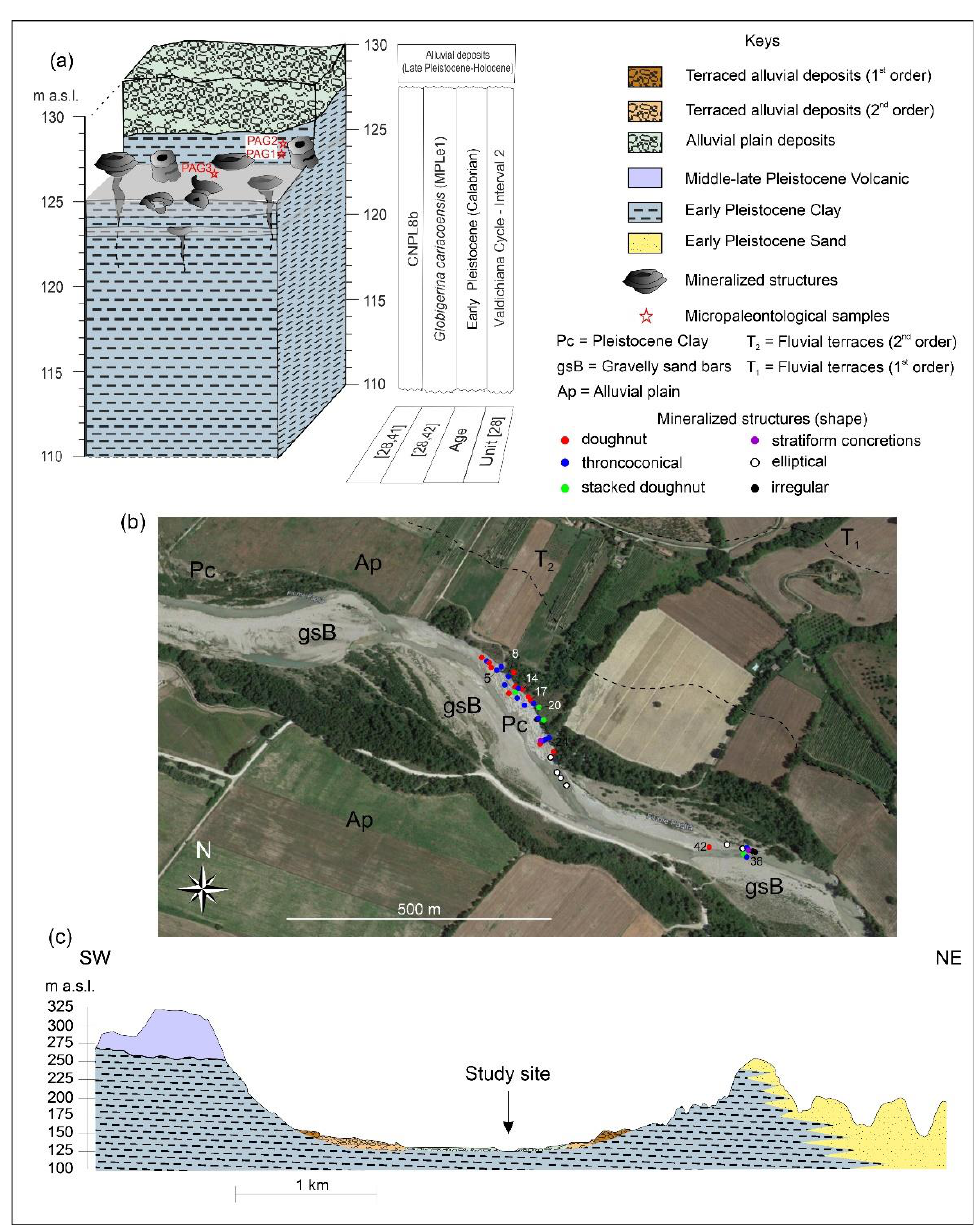
Figure 3. ( a ) Local section of deposits in the study site, stratigraphically referred to as the Early Pleistocene Valdichiana Cycle-interval 2 [28,41,42]. ( b ) Aerial view of the tract of the Paglia River and valley considered in this study, as it appeared in 2016, with the positions of the structures emerging from clay deposits on the riverbed. ( c ) The geological profile, which crosses the Paglia River Valley at the study site (vertical scale is exaggerated).